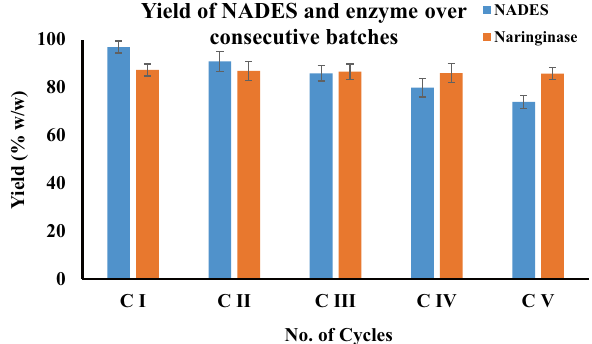
Figure 4. The recycling ability of NADES is determined for 5 cycles. It is observed that the amount of NADES recovered reduces significantly after the third cycle denoting loss of selective partitioning and extraction